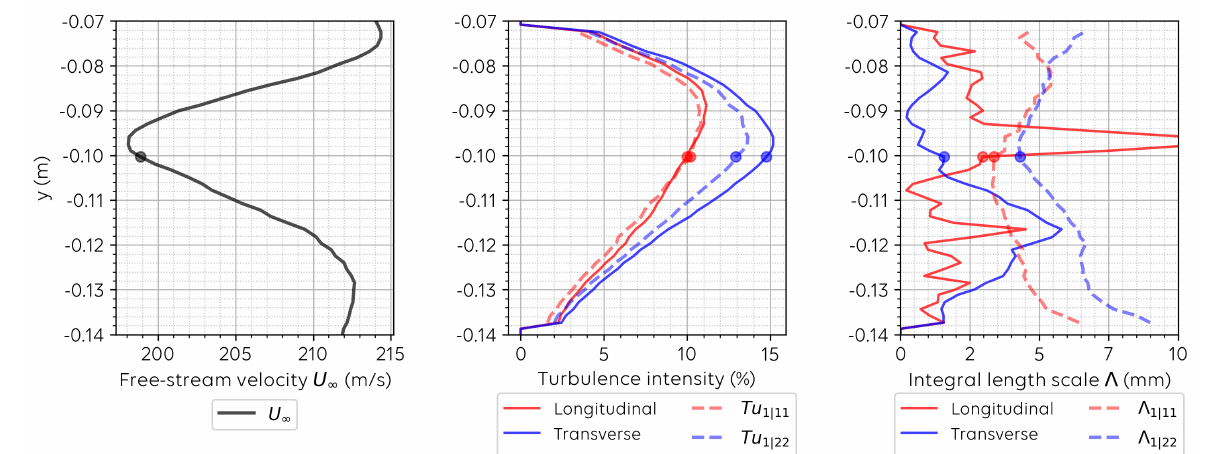
Figure 5. ( Left ): Resultant velocity profile. The thick dot plotted shows a selected probe position, which will be further analyzed in the next section. ( Center ): Turbulence intensity profile of both longitudinal and transverse velocity components calculated directly from each spectrum (solid line) and using the fit technique combined with a von Kármán model (dashed line). ( Right ): Turbulence integral length scale profile of both longitudinal and transverse components calculated directly from the spectrum using the definition (solid line) and using the fit technique combined with a von Kármán model (dashed